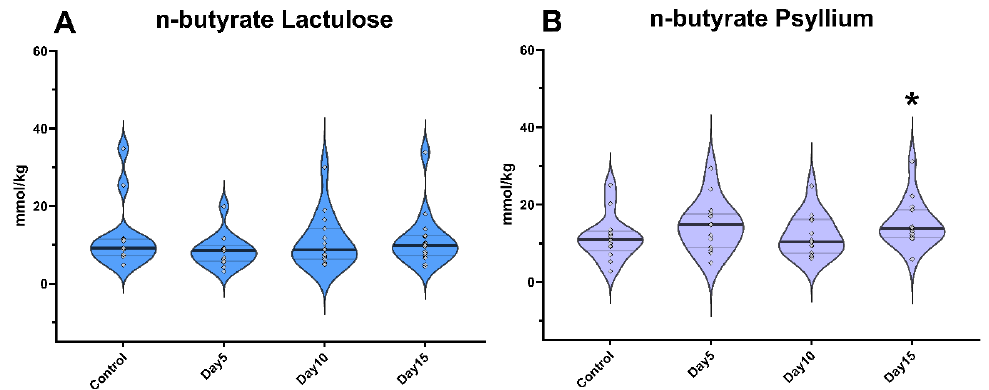
Figure 4. Violin plots show the n-butyrate concentration in the fecal samples following lactulose ( A ) and psyllium ( B ) treatment measured by GC-MS method. Data are visualized using violin plots. Concentrations of single samples are plotted as gray dots; black line refers to the median and gray lines refer to first and third quartiles. * p < 0.05.